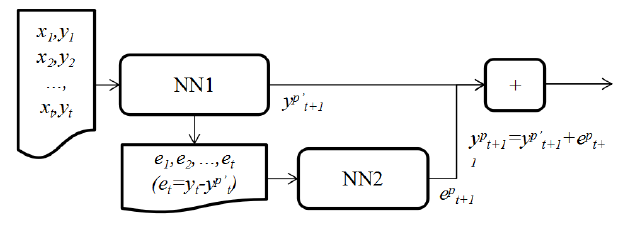
Fig. 6 The proposed model.